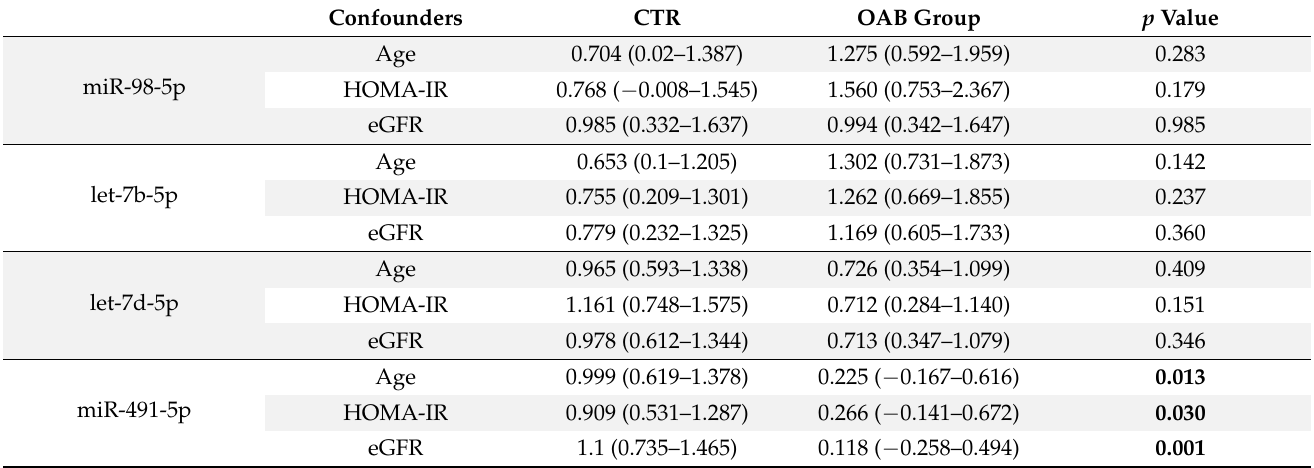
Table 3. miRNA expression (2 − ∆∆ CT ) between the control (CTR) and OAB groups considering